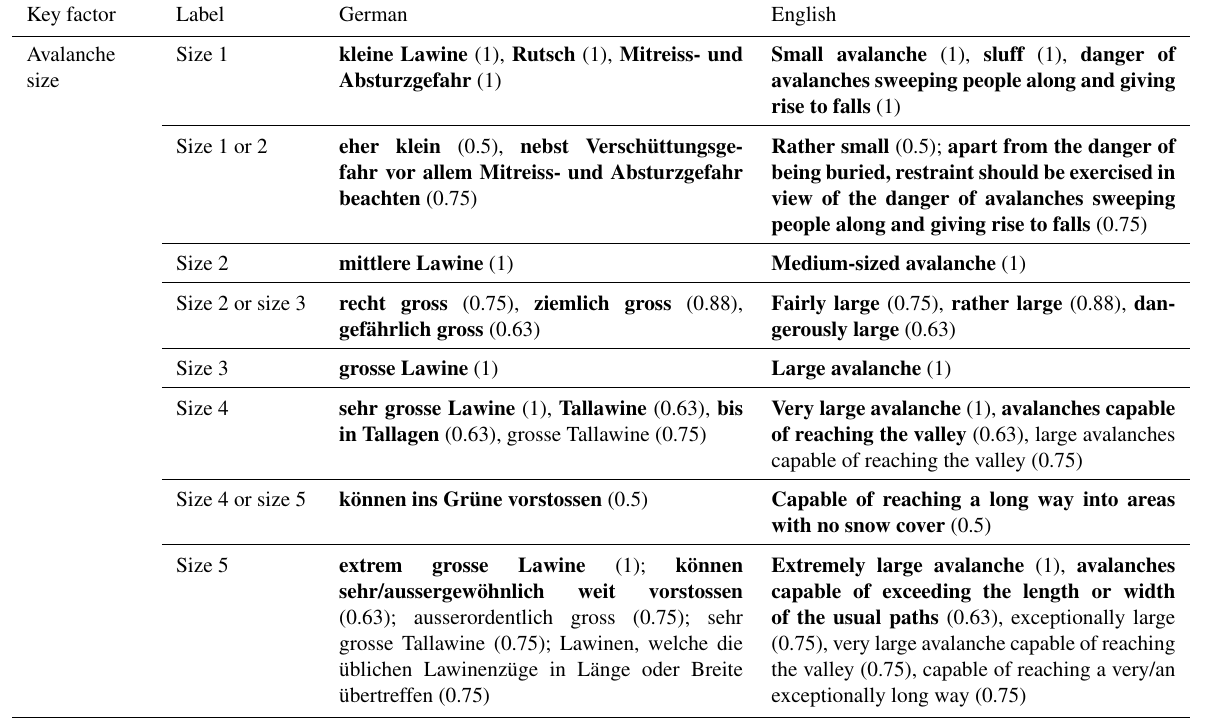
Table A4. Labels assigned to German text values describing avalanche size, including the proportion of forecasters who assigned the re- spective label to this value (in brackets) and their corresponding English translations. Not shown are values describing avalanche size, which could not be assigned to a label (step 1, Sect. 4.1). Note that the proportions shown in the English column are indications only as many-to-one and one-to-many translations were possible (i.e., one English translation for two German words or vice versa). Bold - value was used during the 8 years.